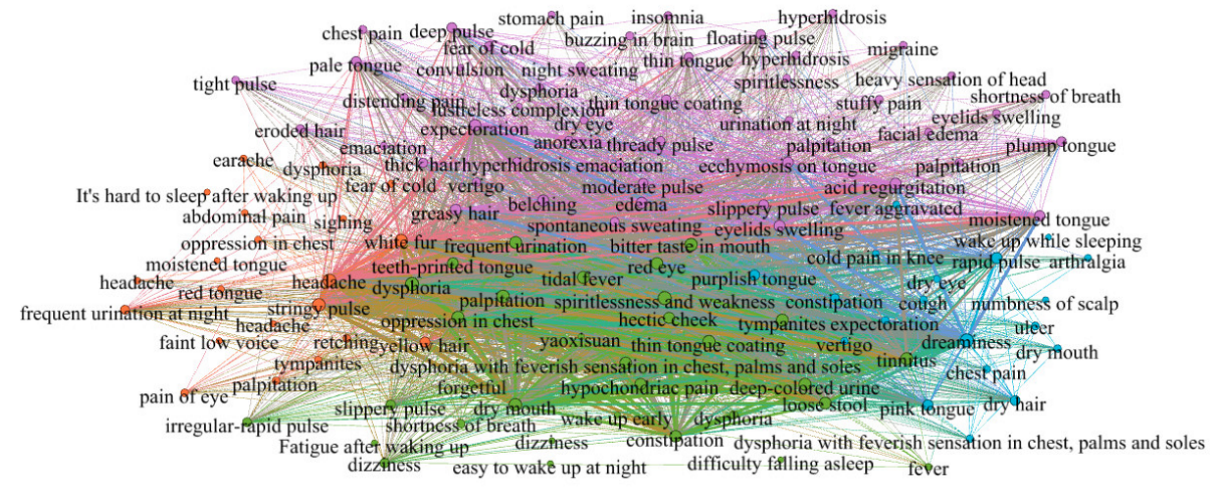
Figure 12. Symptom communities (d=164 and